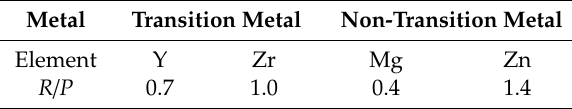
Table 2. The R / P parameter of Mg, Y, Zn, and Zr, data from [12].